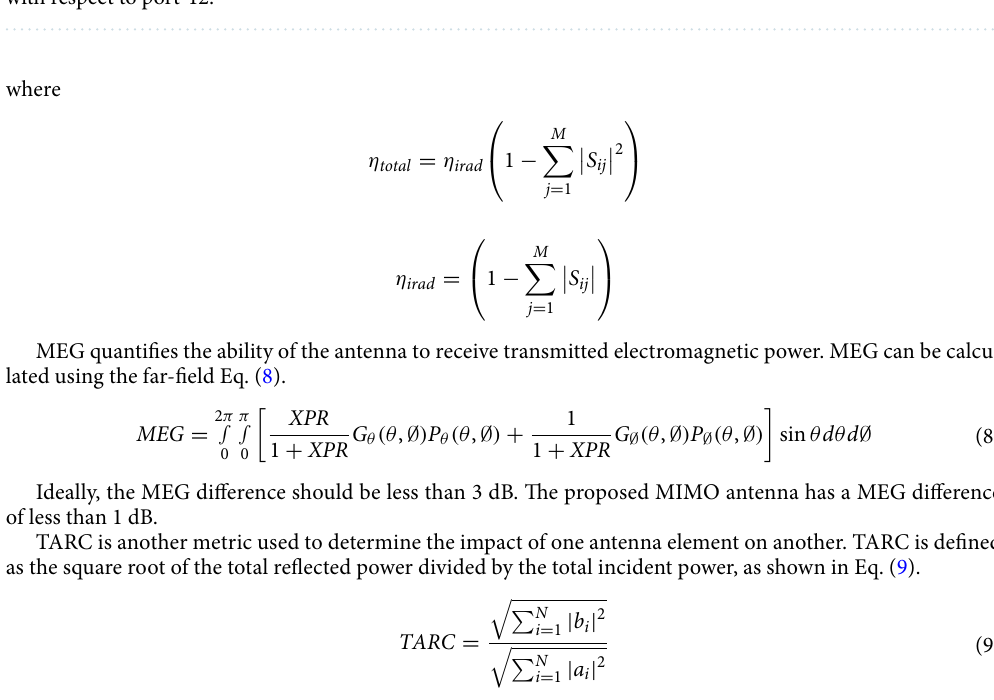
Figure 10. Measured mutual coupling of the twelve-port MIMO antenna: ( a ) with respect to port-1 and ( b ) with respect to